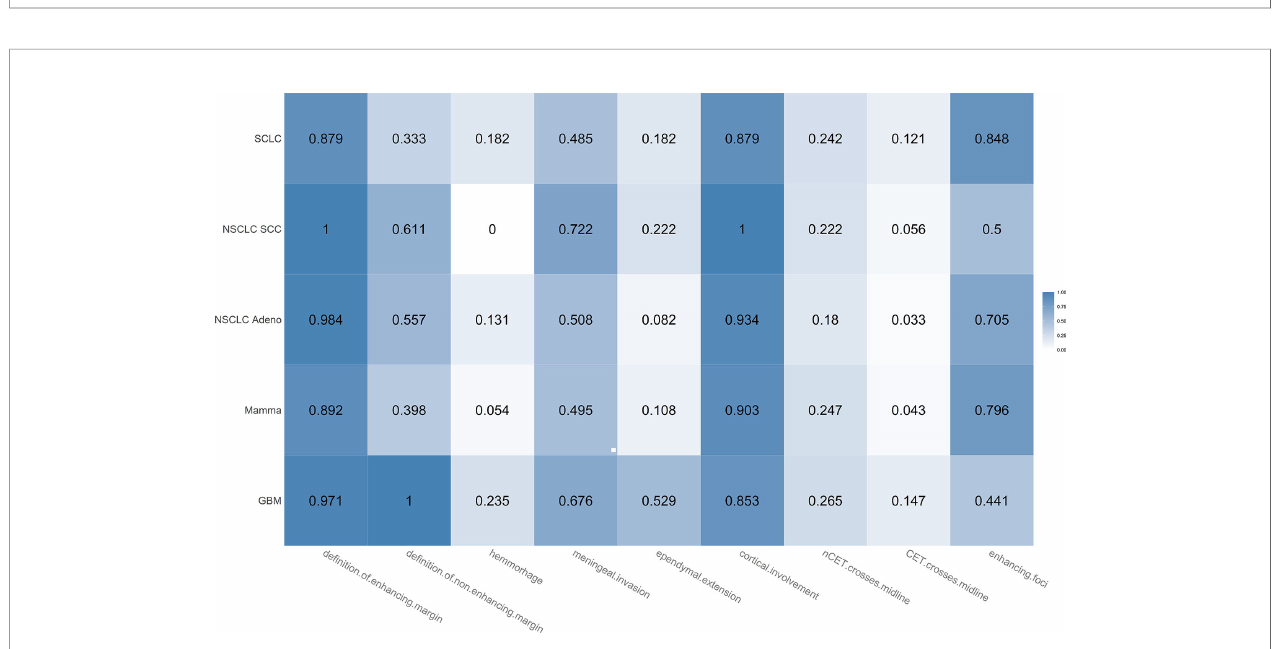
FIGURE 5 | Heatmap showing the proportions for the different appearance-based MR features in case of brain metastases and glioblastoma. Each proportion corresponds to the ratio: number of lesions with feature/total number of lesions of that class. Darker color indicates a larger proportion.